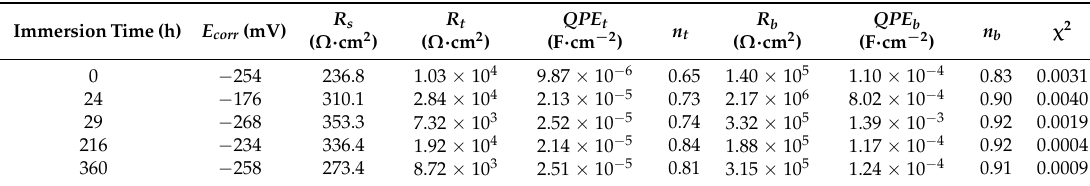
Table 4. Electrical equivalent circuit parameters of the Ti_NT inorg sample.